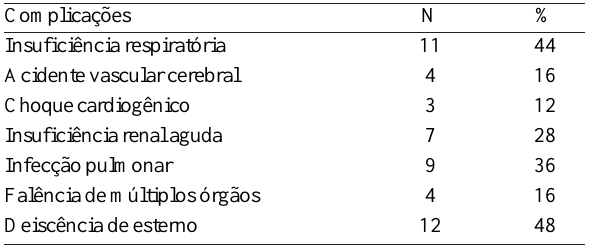
Tabela 3. Análise dos agentes etiológicos dos casos de mediastinite no período pós-operatório pela cultura de